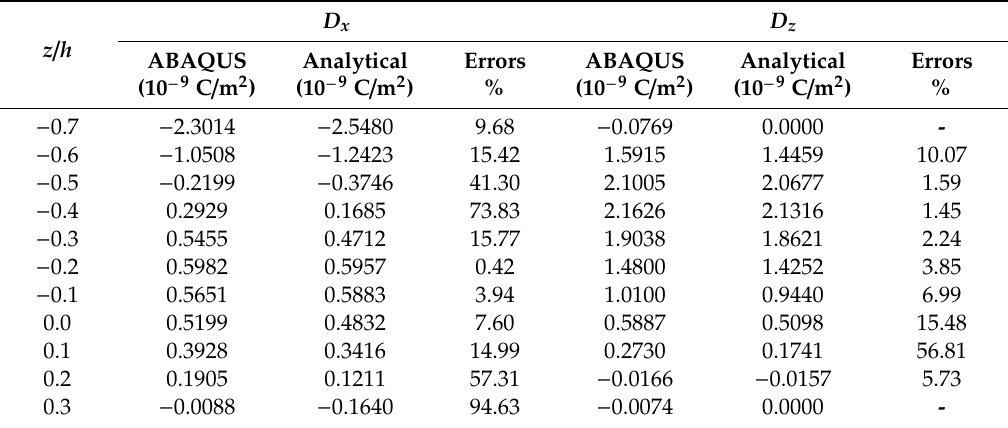
Table 6. Relative errors of two solutions of D x and D z ( x = 0.25 l